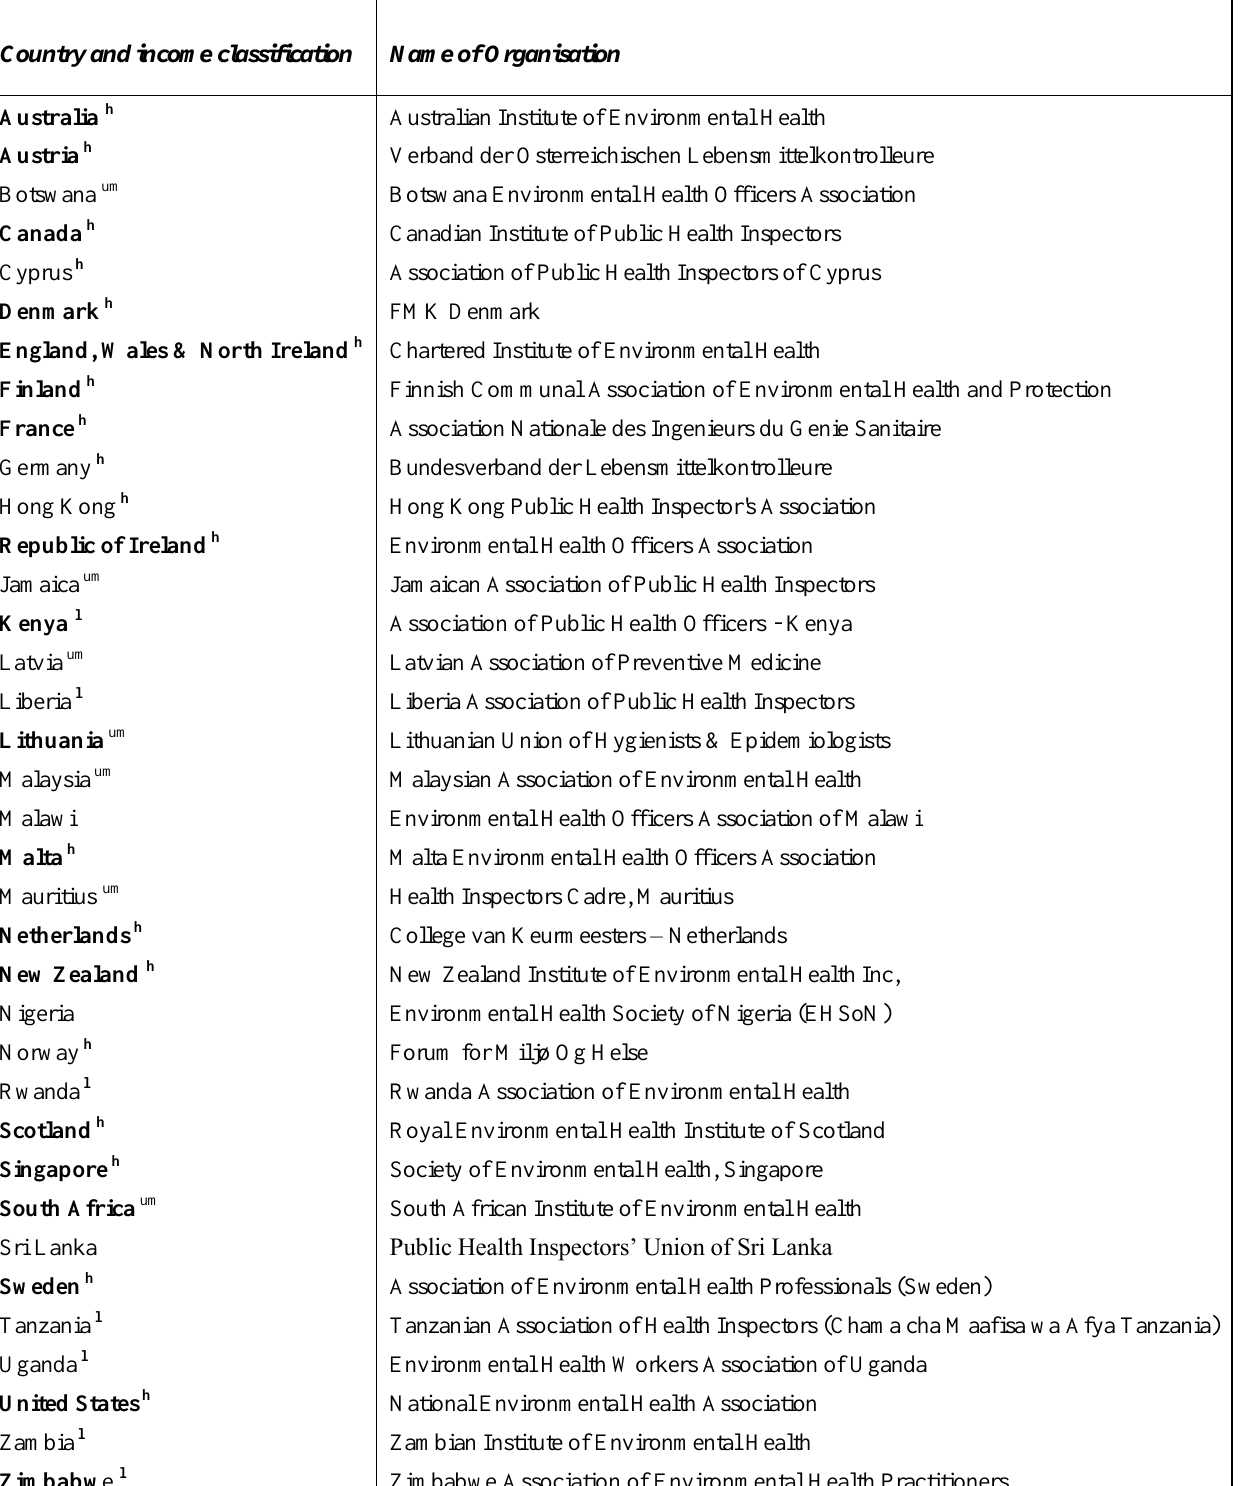
Table 1. Member Organisations of the IFEH by Country (respondents to questionnaire in